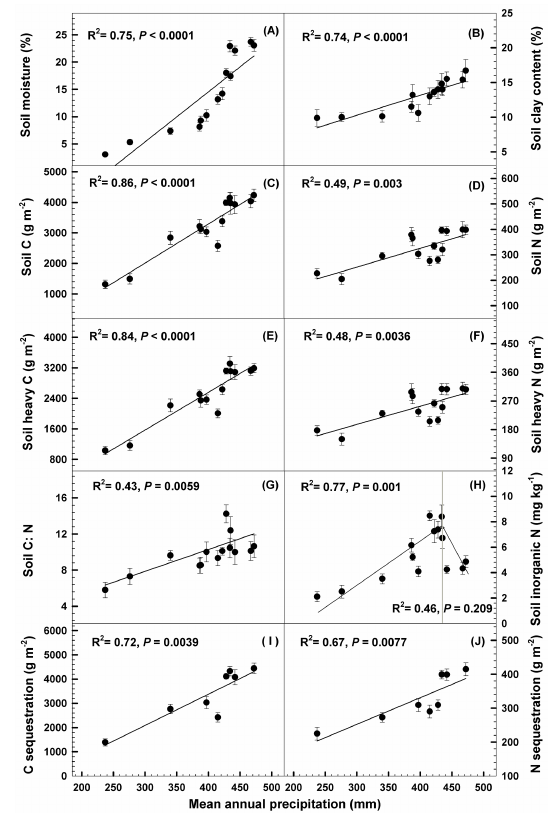
Figure 4. Soil properties and C and N sequestration along the large- scale precipitation gradient in Leymus chinensis grasslands of north- eastern China. Soil moisture ( a ), clay content ( b ), soil total C and N ( c , d ), soil heavy fractions of C and N ( e, f ), soil C : N ( g ), inor- ganic N ( h ), ecosystem C and N sequestration ( i, j